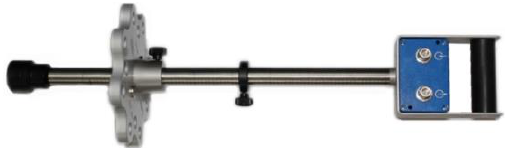
Figure 2. UHF PD probe for standard oil filling valve.